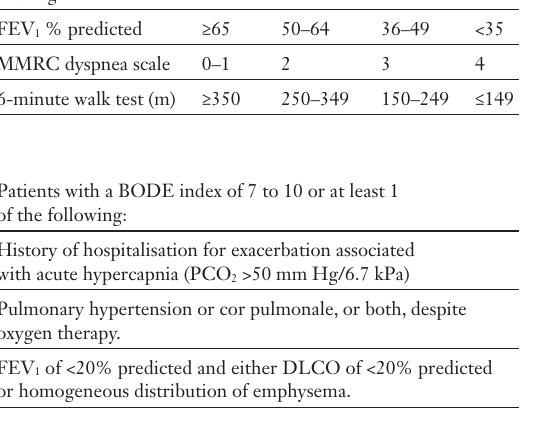
Clinical parameters of the BODE index [16].